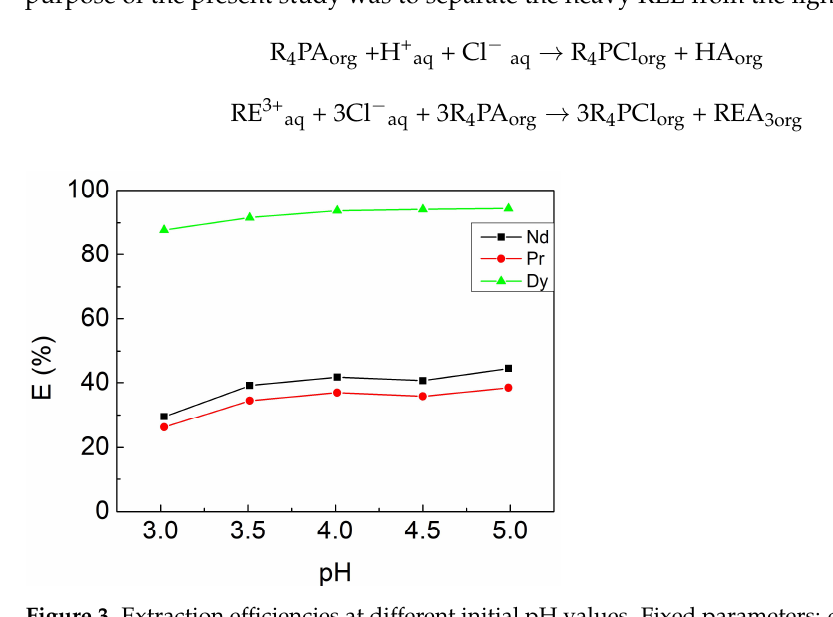
Figure 3. Extraction efficiencies at different initial pH values. Fixed parameters: contacting time of 10 min, 3 mM [Cyphos IL 104], O/A ratio of 1.